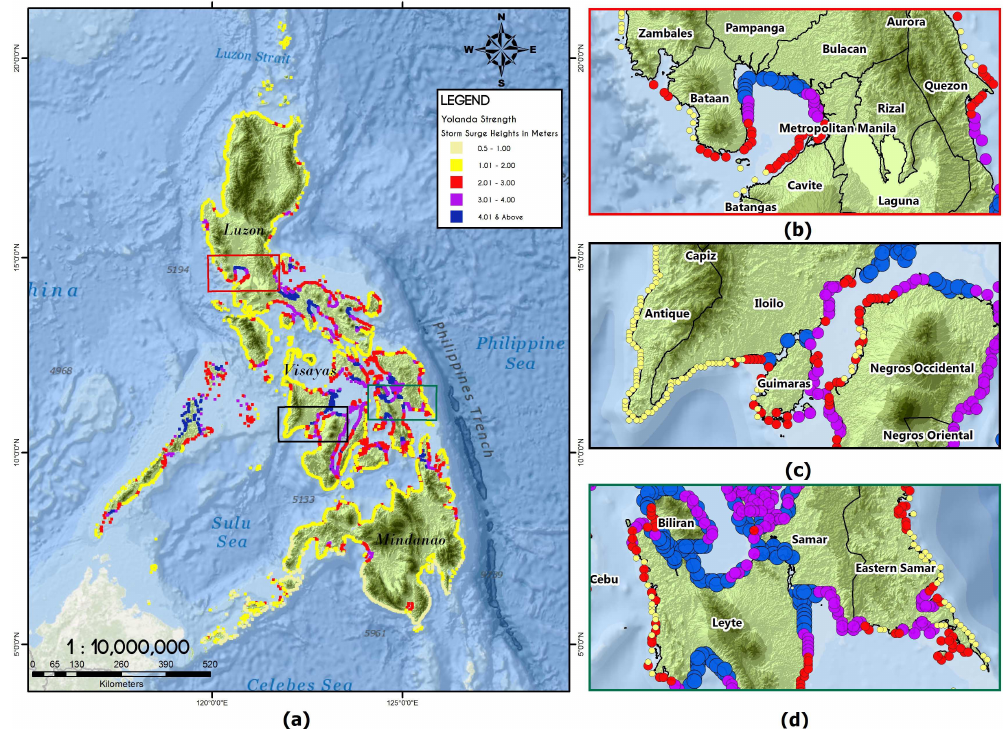
Figure 1. Maximum storm surge height (m) map for the (a) Philippines, (b) Metro Manila, (c) Iloilo, (d)